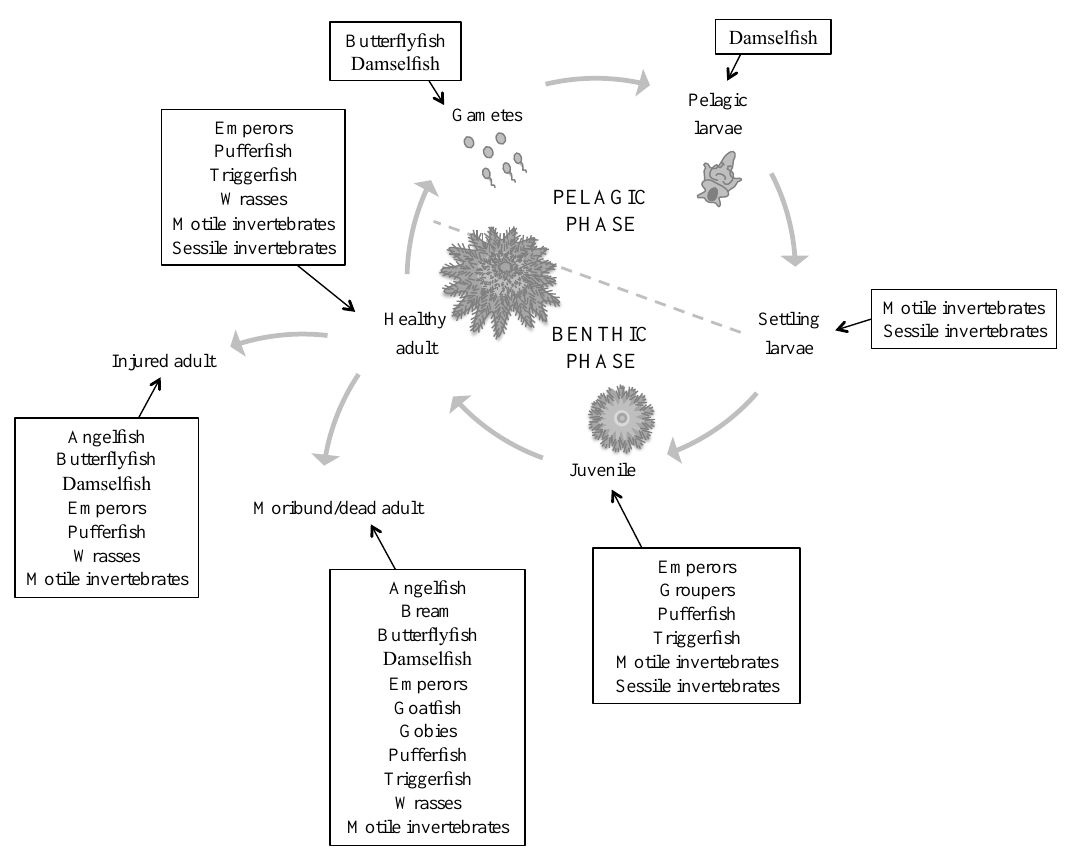
Figure 2. Putative predators of crown-of-thorns starfish across each major life stage. Predators at each life stage are not mutually exclusive. This figure is based on references from Table 1.